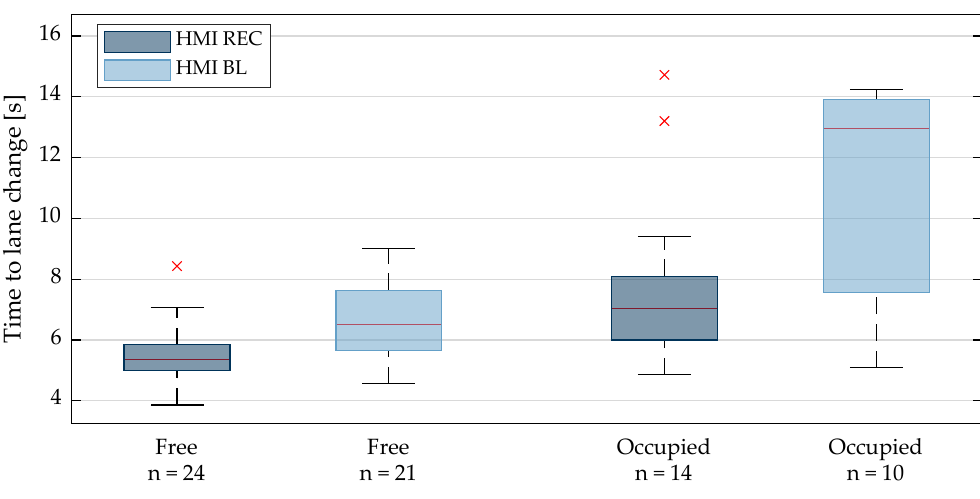
Figure 8. Time to lane change. Outliers are marked as red crosses.